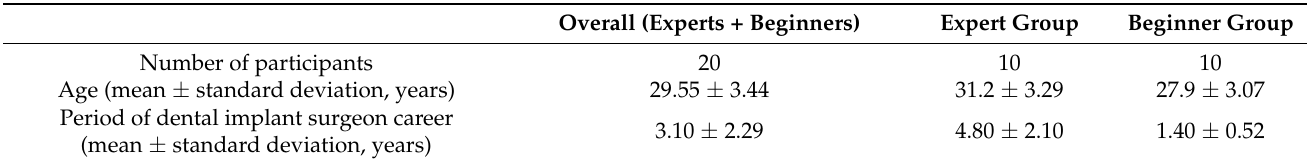
Table 1. Demographic information of the experiment participants.